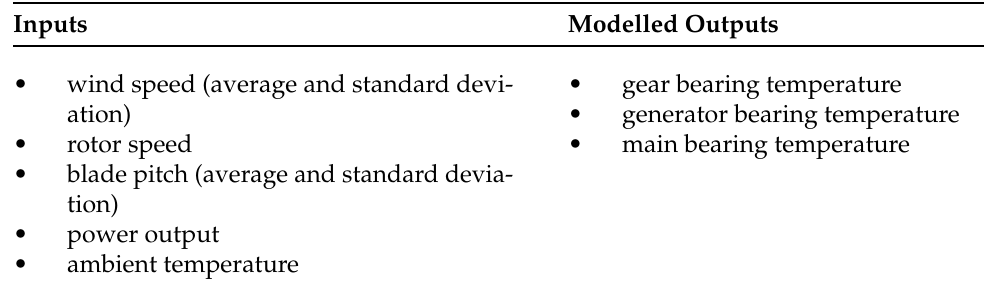
Table 2. Structure of the SVR regressions for the selected